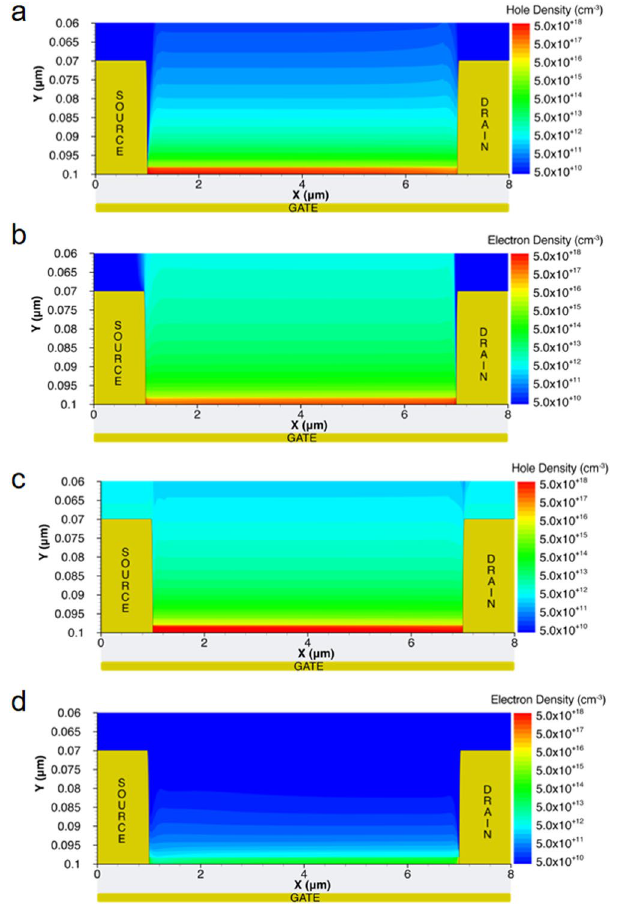
Figure 5. Carrier distribution in PDPP3T ambipolar transistors. 2D numerical simulations. The applied voltages are V D = − 30 V, and V S = 0 V. ( a ) P-type operation (V G = − 40 V) and ( b ) N-type operation (V G = 40 V) without the atmospheric effects. ( c ) P-type operation (V G = − 40 V) and ( d ) N-type operation (V G = 40 V) with the atmospheric